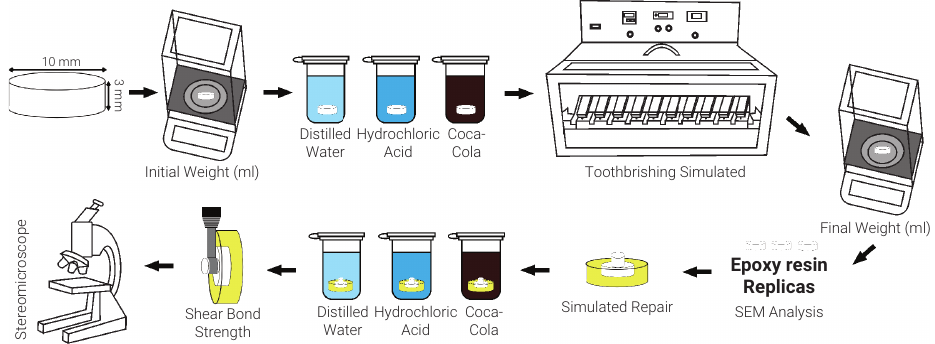
Figure 1. Schematic diagram of experimental